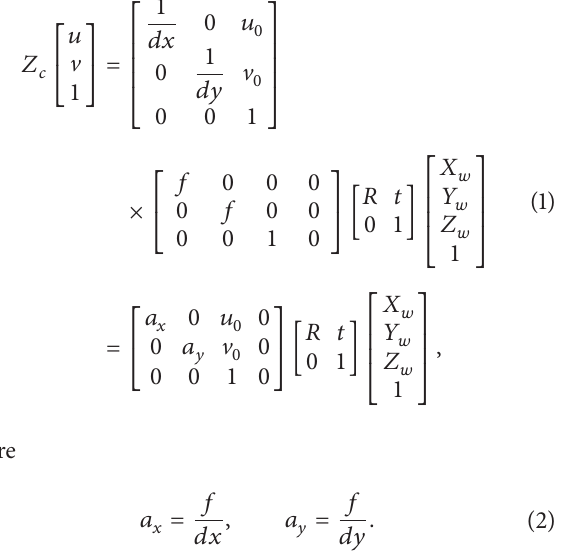
Figure 2: Structured light vision measurement